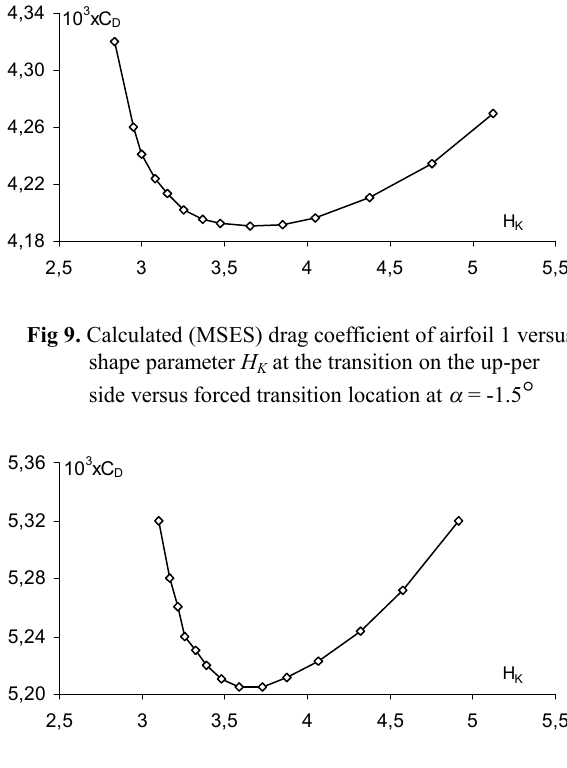
Fig 10. Calculated (MSES) drag coefficient of airfoil 1 versus shape parameter H K at the transition on the upper side versus forced transition location at a = 2